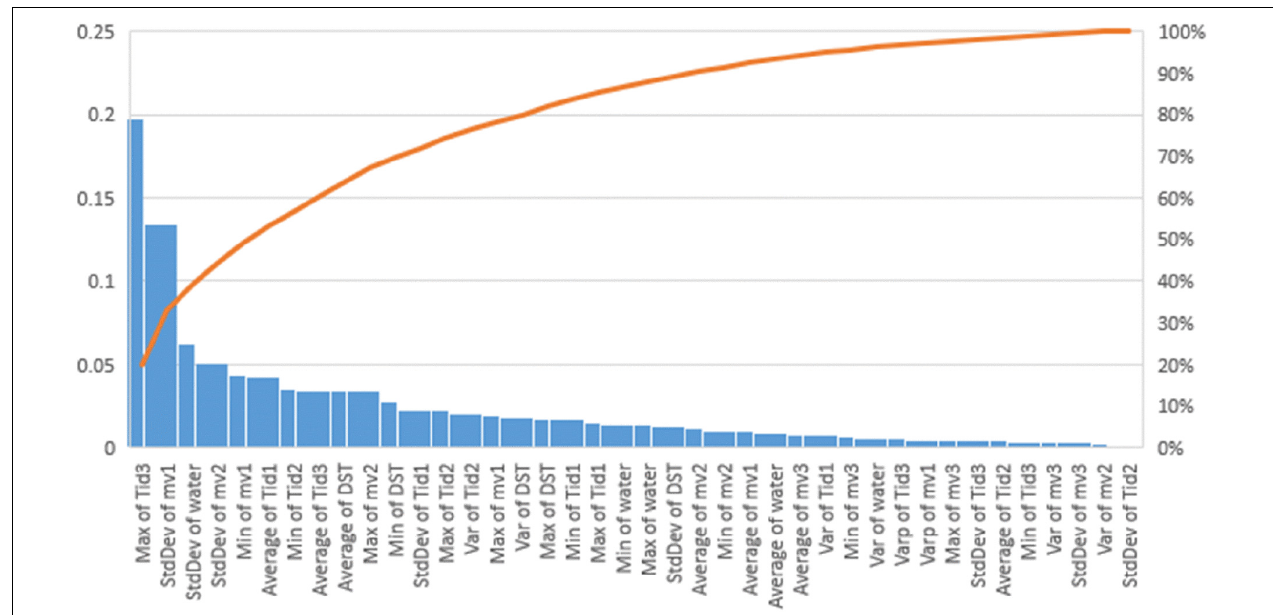
FIGURE 4 | The weights of different statistical measures, obtained in the process of machine learning using input data for the Ajameti well (blue columns). The red curve shows the cumulative percentage of separate weights.